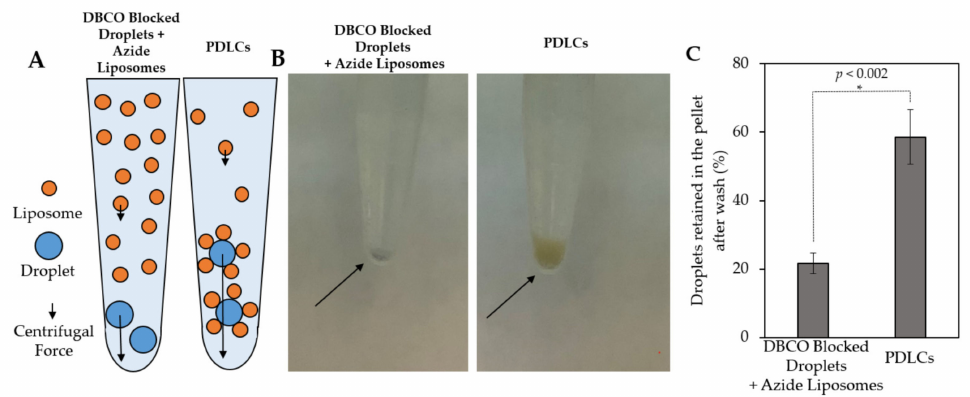
Figure 3. Centrifugation of calcein-loaded PDLCs. ( A ) Schematic figure of centrifugal forces applied to each particle during centrifugation. The magnitude of the centrifugal force has a direct relation with the mass of the particle. ( B ) Samples after centrifugation and removal of the supernatant. The absence of conjugation in DBCO blocked droplets causes the washing of the unbound liposomes. The orange color of the pellet in the PDLC sample is indicative of the existence of quenched calcein in the liposomes that are bound to droplets and retained in the pellet. ( C ) Percent of droplets retained in the pellet after three centrifugations, as determined by reduction in DiD intensity. Droplets in the PDLC sample carry liposomes and are consequently heavier so they experience higher centrifugal forces. The difference is statistically significant ( p < 0.002) and is another indication of tethering droplets to liposomes.